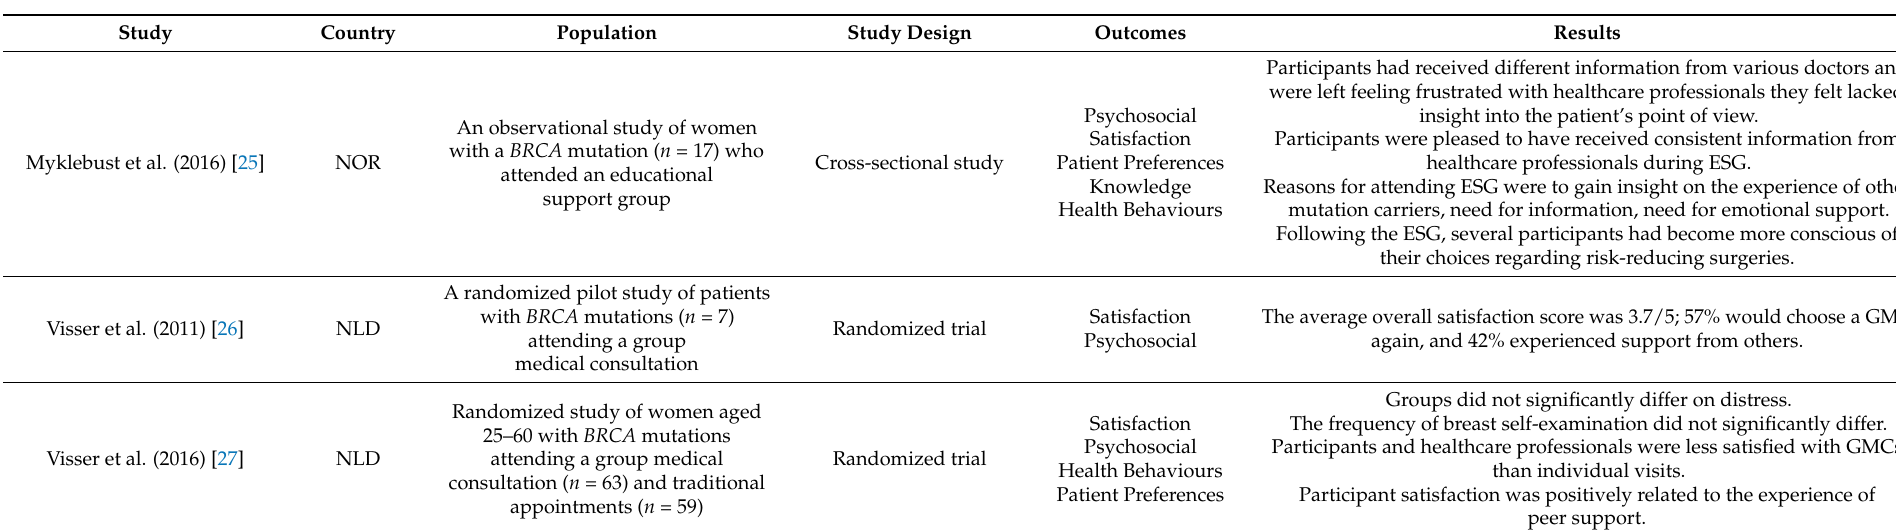
Table 3. Group In-person